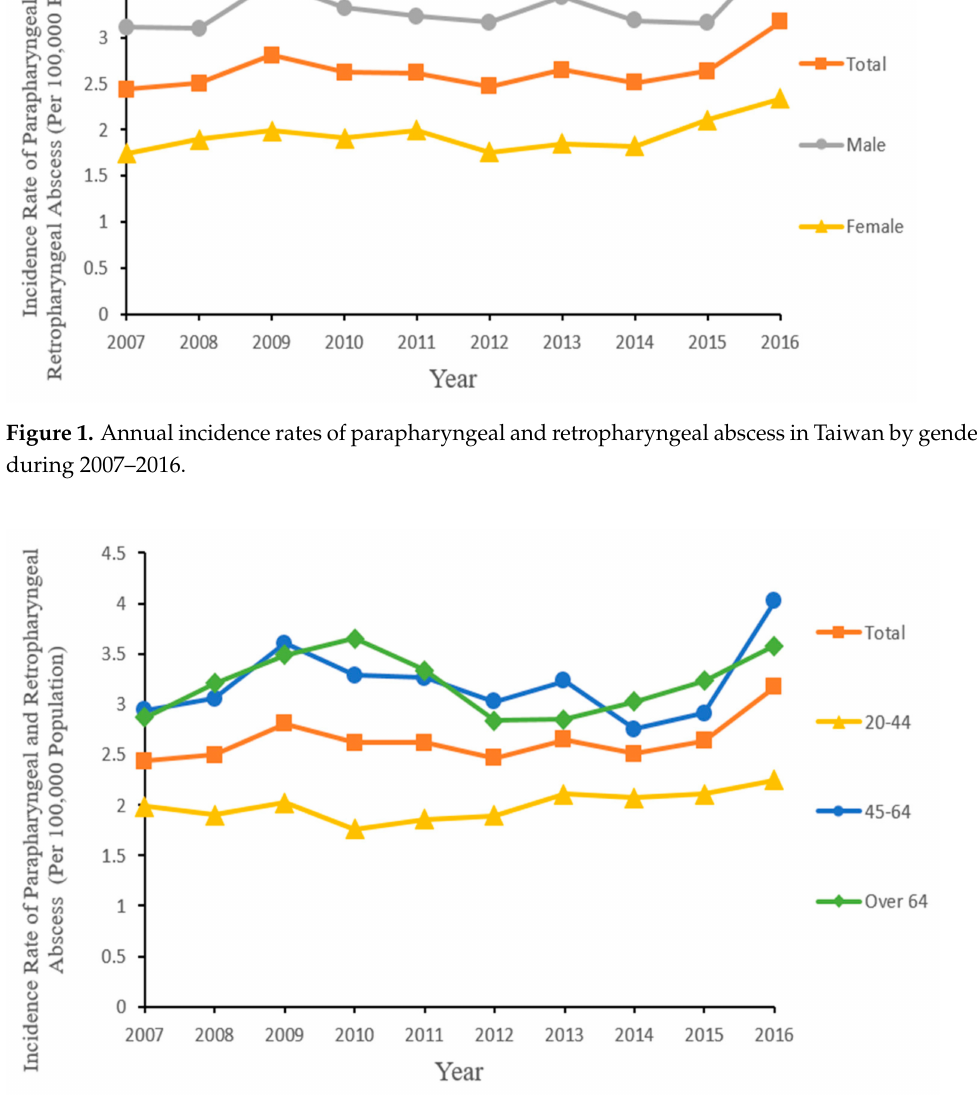
Figure 2. Annual incidence rates of parapharyngeal and retropharyngeal abscess in Taiwan by age group during